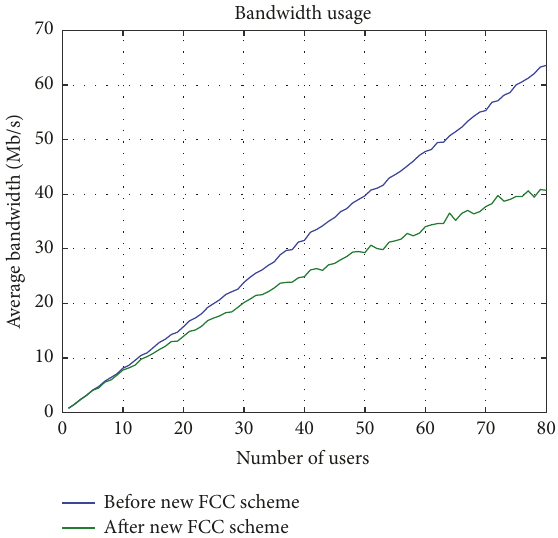
Figure 13: Bandwidth behavior in terms of the number of users.